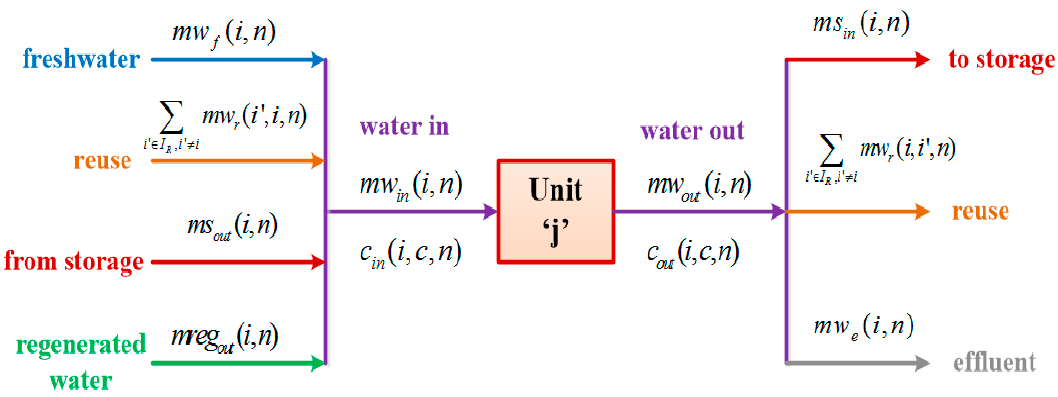
Figure 1. Superstructure for water mass balance in each unit j . Constraint (13) states that total inlet water in the washing unit should be the summa- tion of reused water from other units, freshwater requirement, water received from the central water storage tank, and water coming out from the regeneration unit: mw in ( i , n )